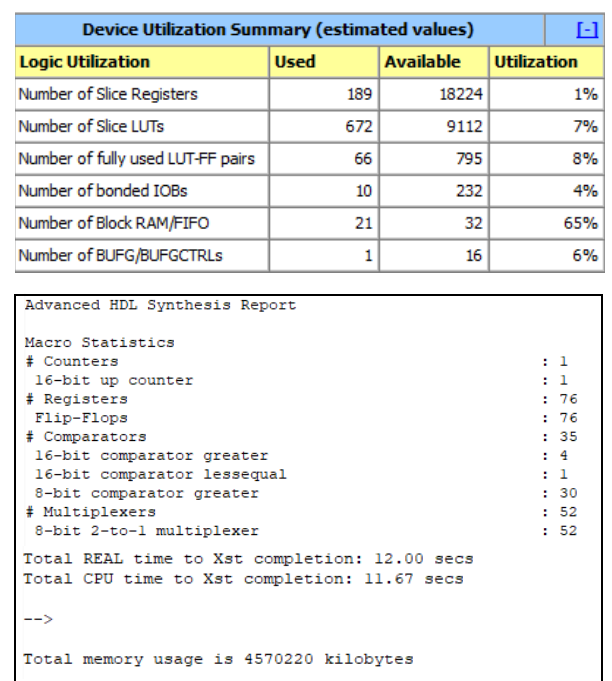
Fig. 12. Results from the design synthesis